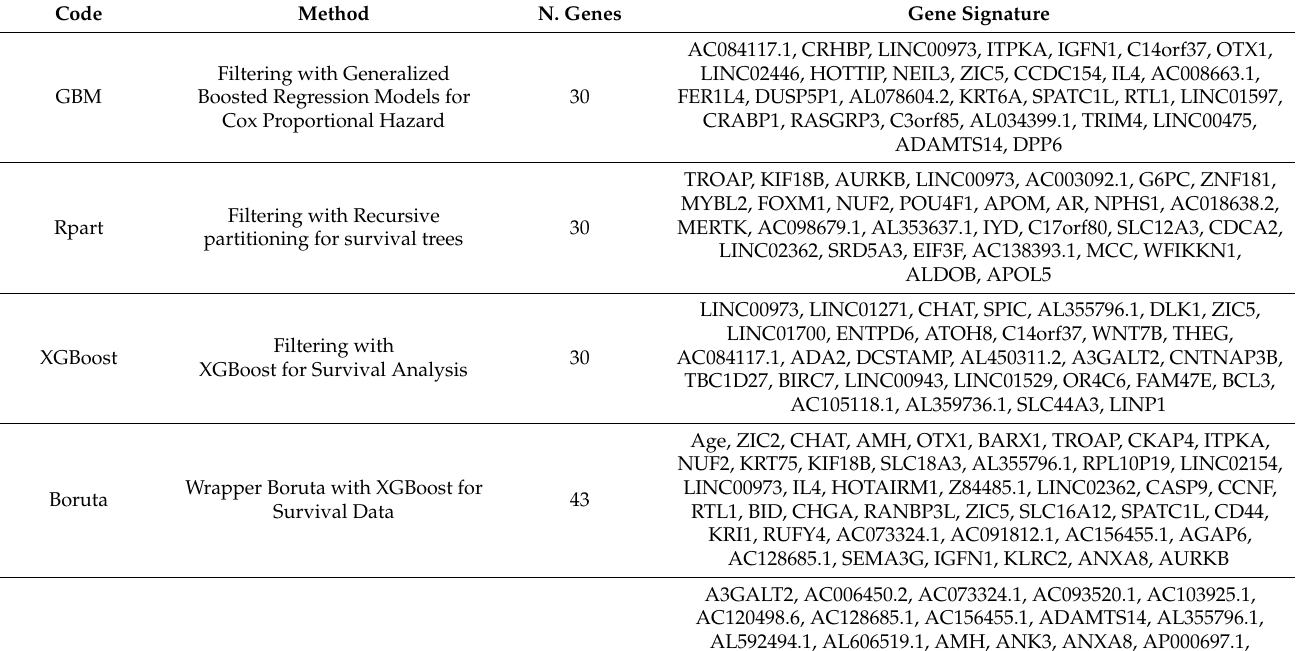
Table A2. New gene signatures of ccRCC obtained by state-of-art machine learning for feature selection methods: Recursive Feature Elimination, Boruta, Rpart, GBM and XGBoost for Survival.